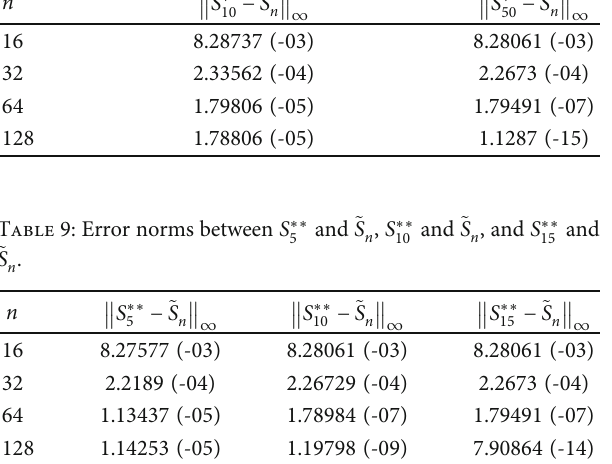
Table 8: Error norms between S ∗ n